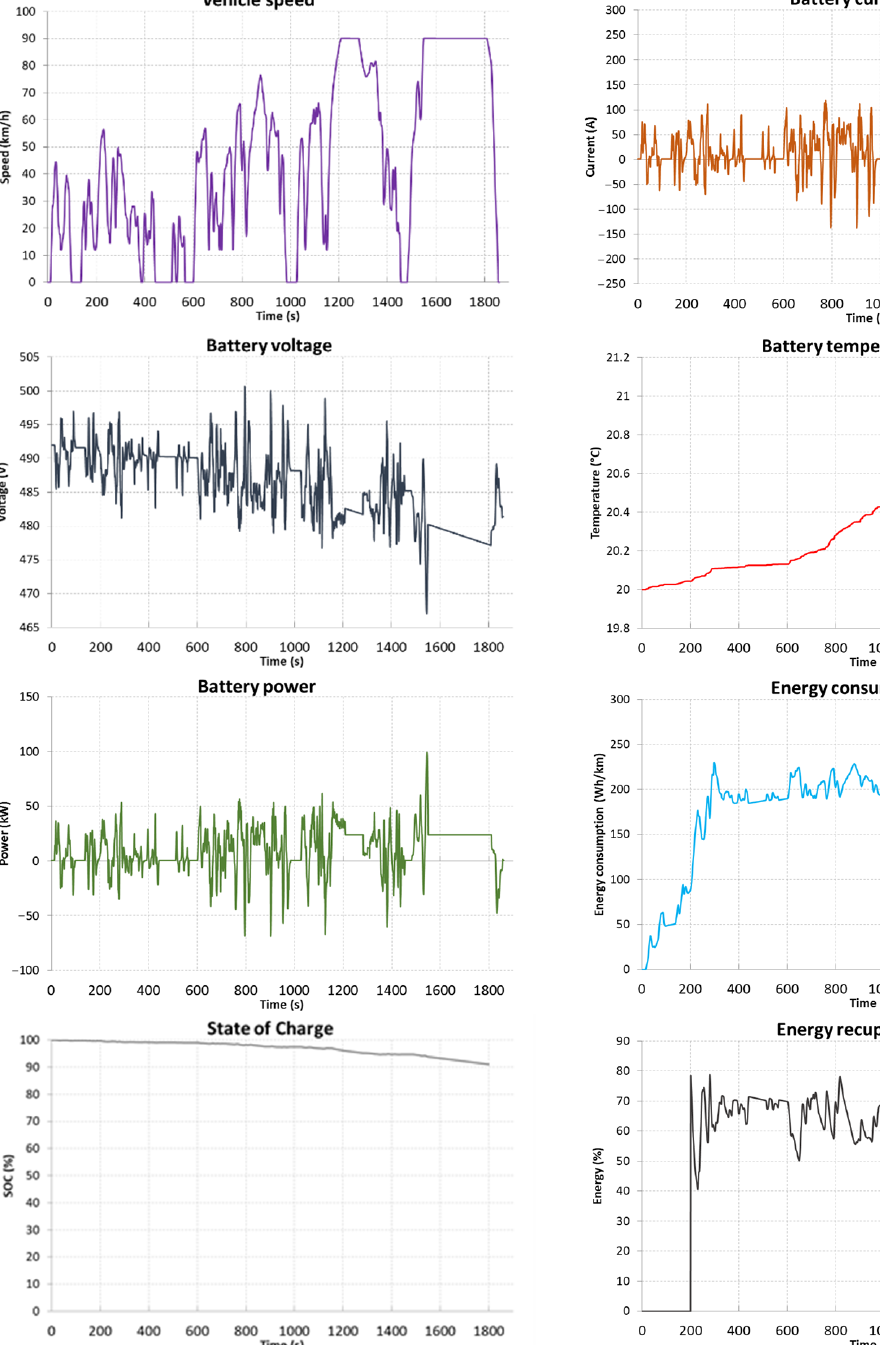
Figure 17. WLTP results of simulation tests for the 4 × 4 drive system with Type 3 energy storage.